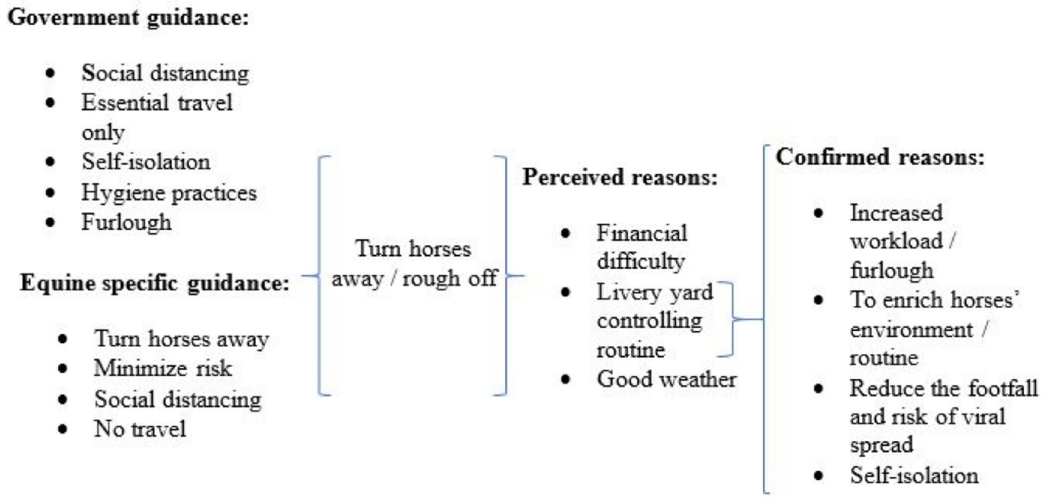
Fig 1. Perceived and actual reasons for turning horses away during the COVID-19 lockdown. Horse owners, veterinarians, farriers and welfare centre managers discussed their perceived reasons that horses may have been turned away to grass during lockdown. The confirmed reasons include actual reasoning employed by interviewees, or their recollections of reasoning used by others, for turning horses away to grass despite the animals’ susceptibility to laminitis and obesity.